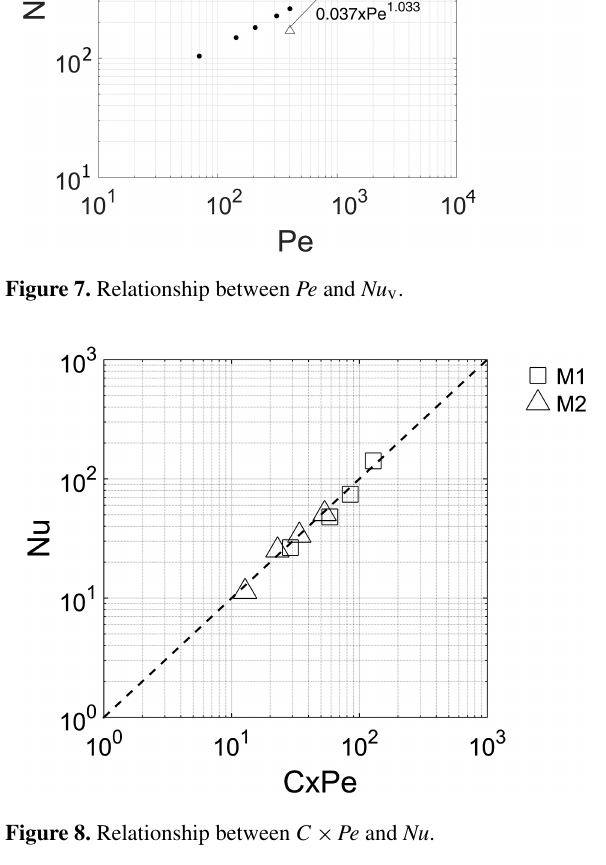
Figure 8. Relationship between C × Pe and Nu .